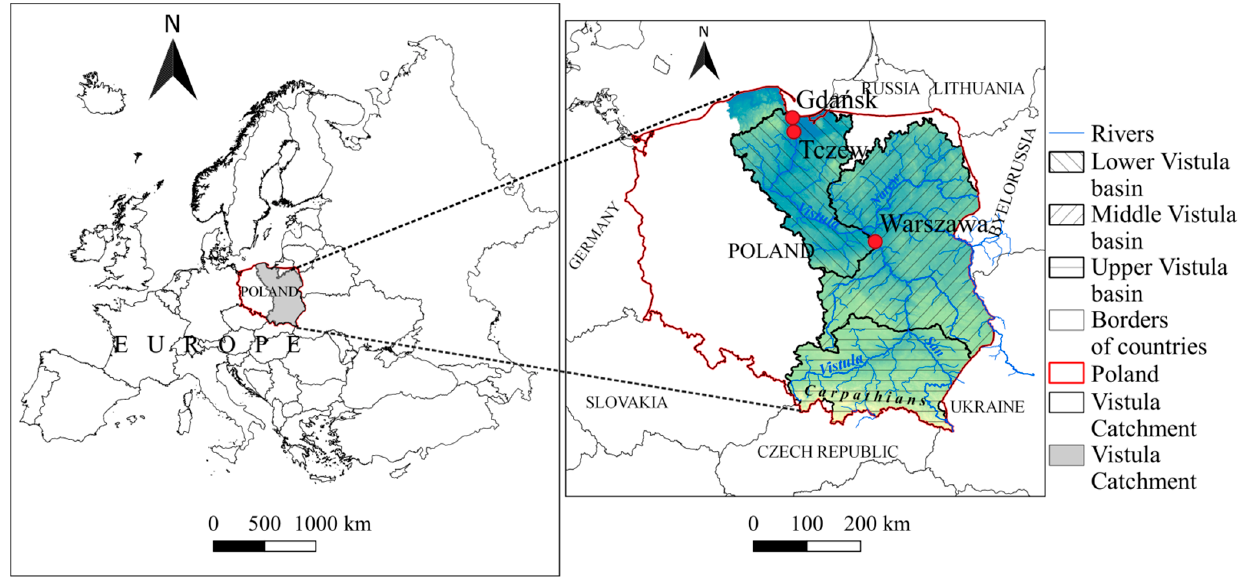
Figure 1. The Vistula River basin and its geographic division [20].